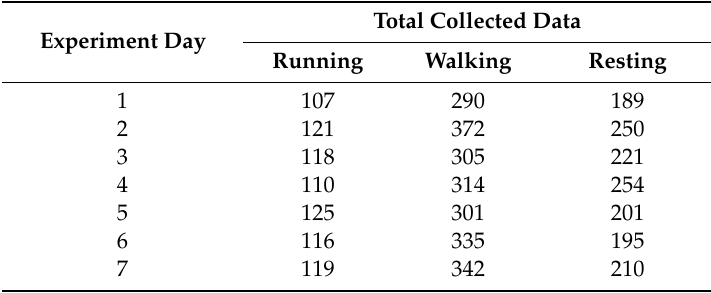
Table 3. Table of the total collected data during seven days experiment for all three goat’s behavior.